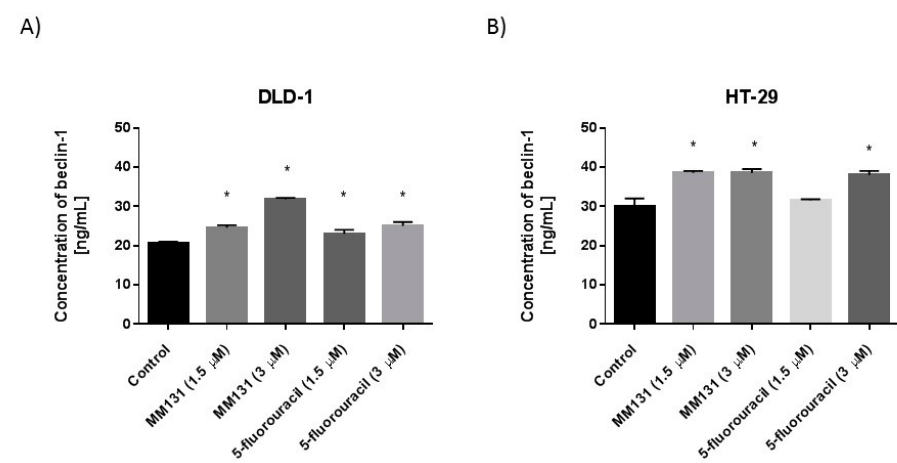
Figure 11. Quantification of cathepsin B by ELISA. Bar graphs demonstrating cathepsin B concentration in DLD-1 ( A ) and HT-29 ( B ) colorectal cancer cells after 24 h of incubation with MM131 and 5-fluorouracil. n = 3 in duplicates, * p < 0.05 versus respective control group.